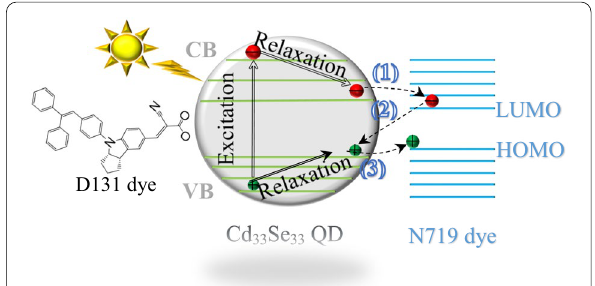
Fig. 1 Illustration of different charge transfer pathways upon the photoexcitation of the Cd 33 Se 33 QD functionalized with N719-D131 dyes: (1) electron transfer ( et ) from the CB edge of the QD to the LUMO of the dye, (2) electron back transfer from the LUMO of the dye to the QD VB edge ( re ), and (3) hole transfer ( ht ) from the QD VB edge to the HOMO of the